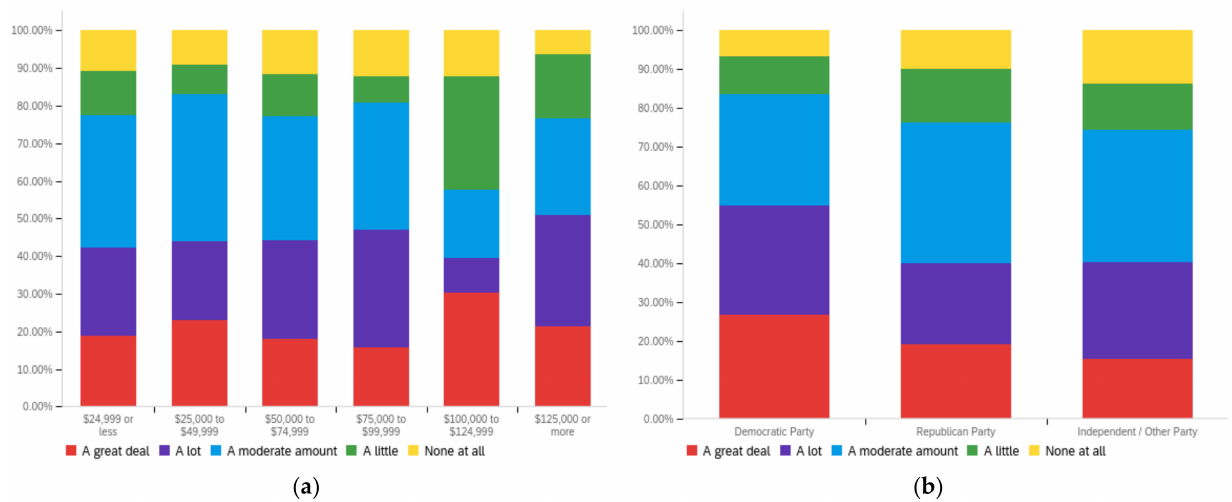
Figure A29. Cont